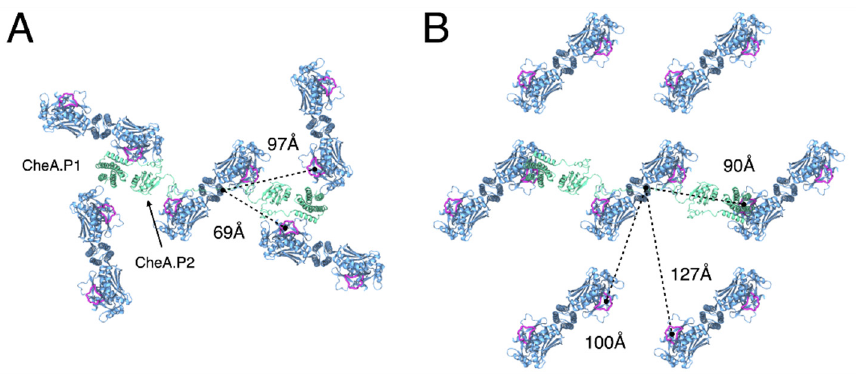
Figure 6. Difference in the intermolecular distance and the relative orientation of neighbouring CheA molecules between p6 and p2 chemosensory array architectures. ( A ) The p6 architecture. ( B ) The p2 architecture. Rough distances between a given CheA monomer, as measured from the end of the P2-P3 linker (residue I264), and ATP-binding sites on neighbouring CheAs that may be accessible in a trans-fashion by the associated P1 domain (dashed lines). The CheA.P1 and CheA.P2 domains are modelled for a centralized CheA dimer and shown in green. The ATP lid (residues 455–475) of each CheA monomer is shown in purple. Receptors, CheW, and CheA.P5 are not shown for clarity.